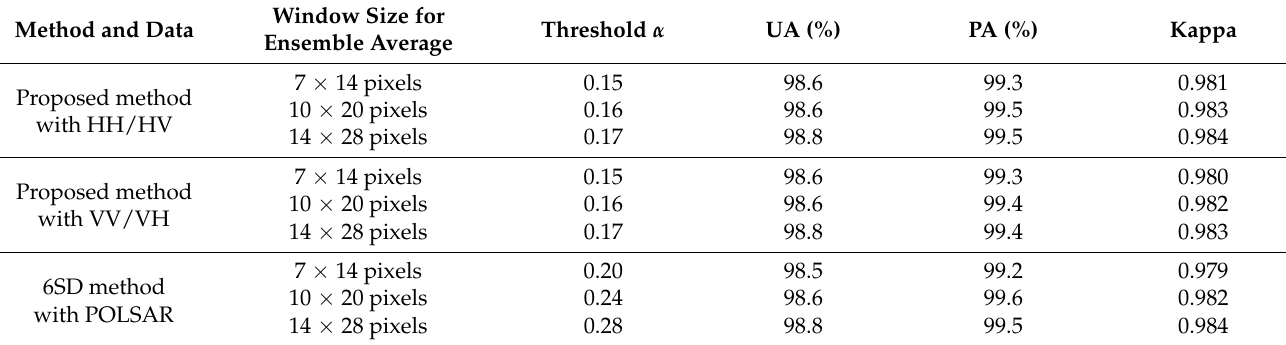
Figure 2. Forest map at Rio Branco generated by using the proposed method with HH/HV data acquired on 5 January and 19, 2018, and a window size of 10 × 20 pixels. The red rectangle shows the reference data area. ( a ) Mosaic image acquired by Planet/Dove from December 2017 to May 2018. The white rectangle shows the observation area of PALSAR-2. ( b ) RGB image generated by the proposed method: ground scattering is in red and blue and volume scattering is in green. ( c ) Forest map generated by the proposed method. Table 4. Forest classification performance at Rio Branco.